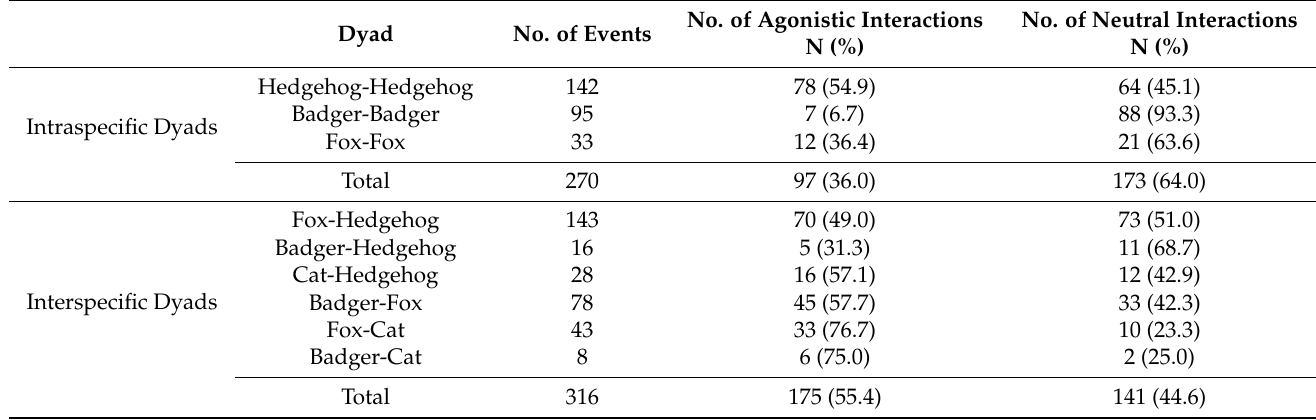
Table 2. The number of events recorded from videos sent in by volunteers for each dyad of four species of urban mammal (Western European Hedgehog ( Erinaceus europaeus ), Eurasian badger ( Meles meles ), Red fox ( Vulpes vulpes ), and domestic cat ( Felis catus )) and the number and relative percentage of agonistic or neutral interactions.